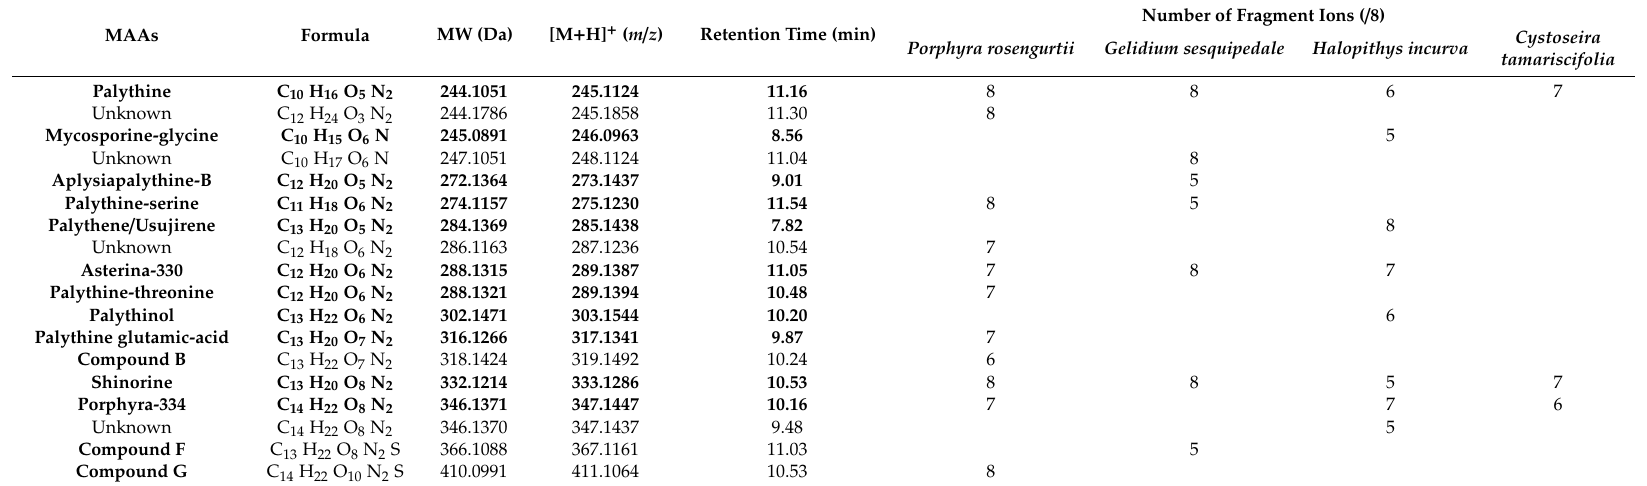
Table 8. Candidate-MAAs detected in four di ff erent algal species using the Fragment Ion Search (FISh) in ddMS 2 / MS3 Untargeted Analysis and validated by subsequent Targeted